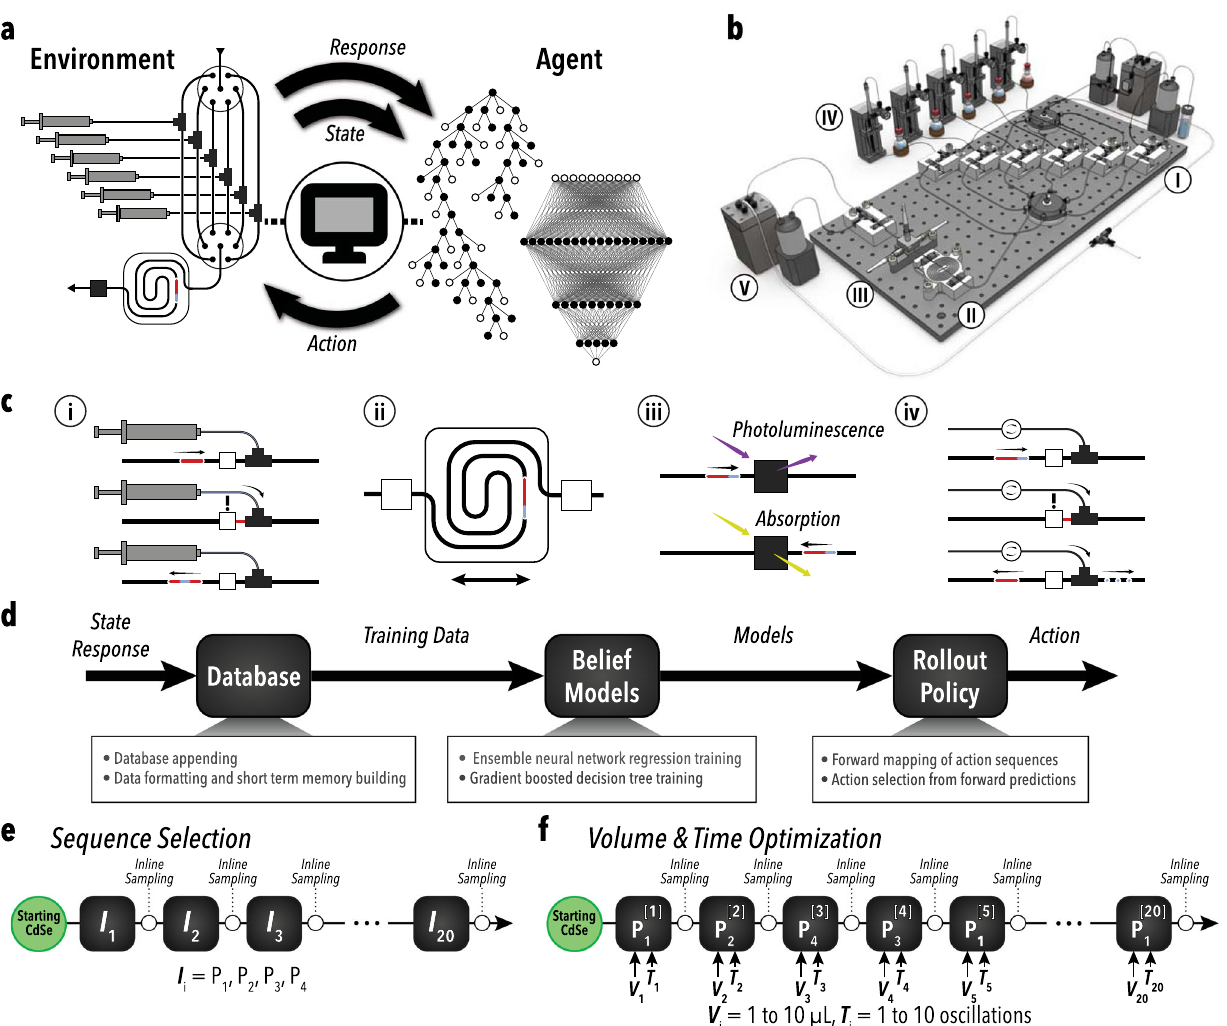
Fig. 2 | Overview of AlphaFlow. a Illustration of an RL-based feedback loop between the learning agent and the automated experimental environment. b Schematicof fullreactorsystemwith(I)reagentinjection,(II)dropletoscillation, (III) optical sampling, (IV) phase separation, (V) waste collection, and (VI) re fi ll modules. c Schematics of individual module functions corresponding to (i) for- mulation, (ii) synthesis, (iii) characterization, and (iv) phase separation. d General fl ow diagram of learning agent condition selection process. e , f Block diagram of the reaction space exploration campaigns, sequence selection, and